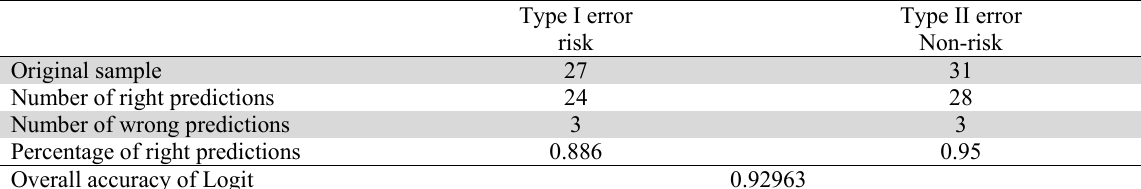
The cost of form I errors and form II